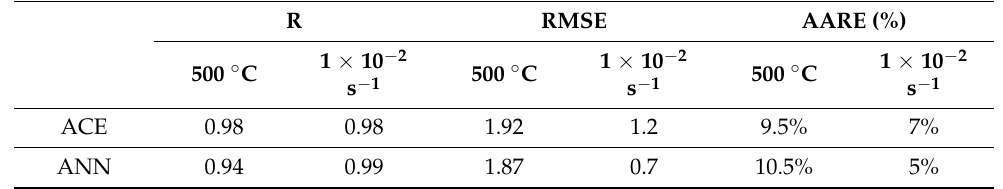
Table 5. Performance indicators R, AARE (%), and RMSE values of the proposed models after prediction of the flow behavior of the investigated alloy via a cross-validation